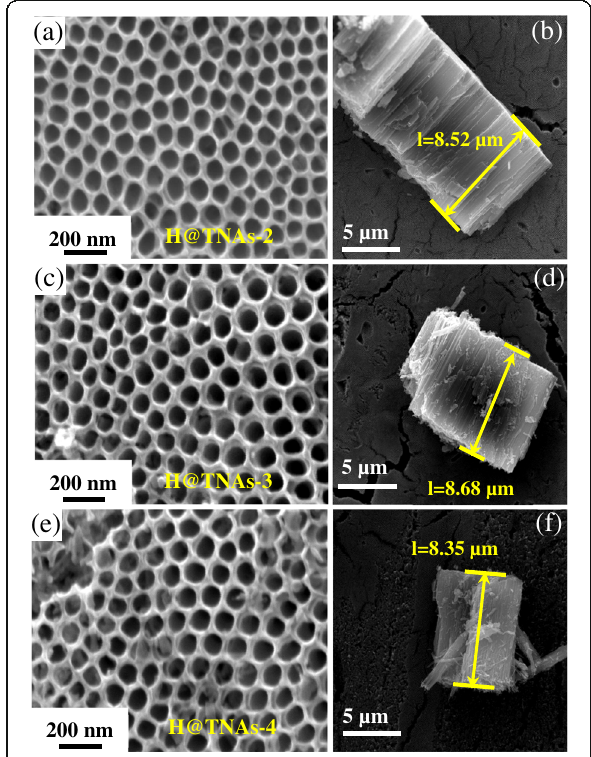
Fig. 7 SEM images of a H@TNAs-2, c H@TNAs-3 and e H@TNAs-4. b , d , f The cross-sections of H@TNAs-2, H@TNAs-3 and H@TNAs-4, respectively. The as-prepared H@TNAs have a diameter of 85 ± 10 nm and a tube length of 8.5 ± 0.3 μ